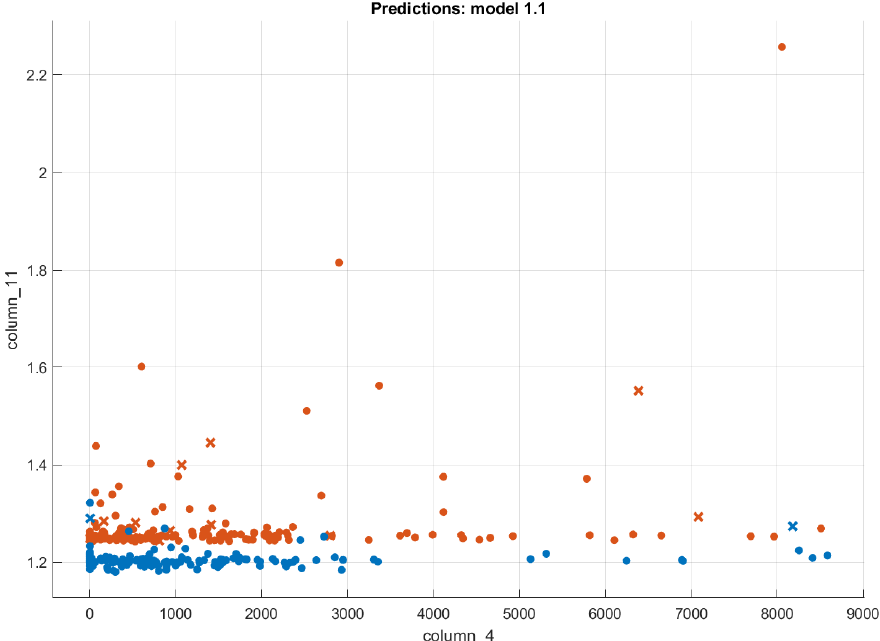
Figure 5. Obtained scatter plot after training the model with new features (2nd group of data; or-